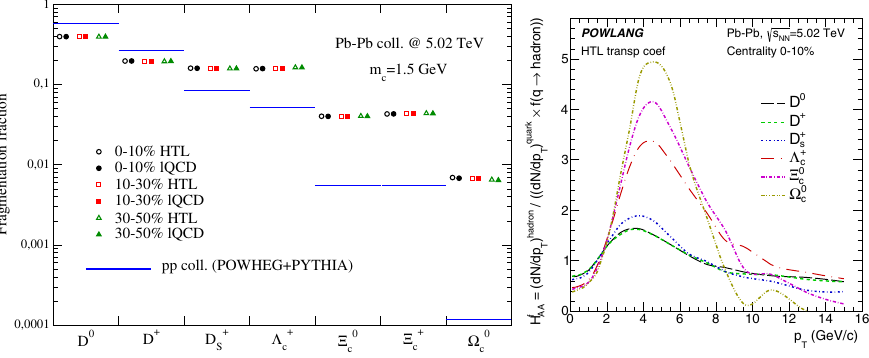
Figure 3. Left panel: charm fragmentation fractions in Pb-Pb collisions for di ff erent centrality classes and transport coe ffi cients; also shown, in blue, the results obtained for proton-proton collisions at the same center-of-mass energy obtained with the POWHEG-BOX package [10]. Right panel: hadron-to- quark ratio of the normalized p T -distributions for the di ff erent species of